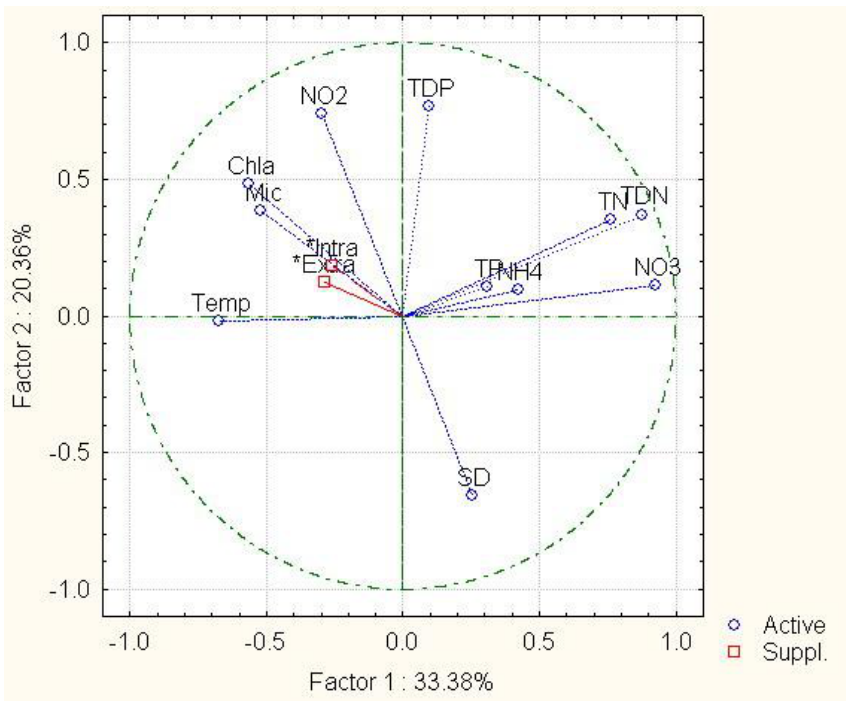
FIGURE 11. Scatter plot of first two components from a PCCA performed with 11 physiochemical or biological variation and MC variables from all samples (○, the active variables; □, the supplementary; Extra: extracellular MC content; Intra: intracellular MC content; Mic: Microcystis biomass; Temp: temperature; TN: total nitrogen; TP: total phosphorus; SD: Secchi